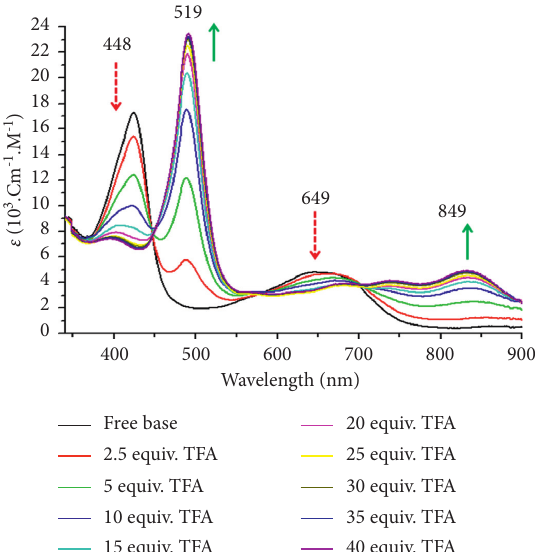
Figure 2: UV-Vis absorption spectral changes of benziporphyrin 2 (2.85 × 10 − 5 M, in CH